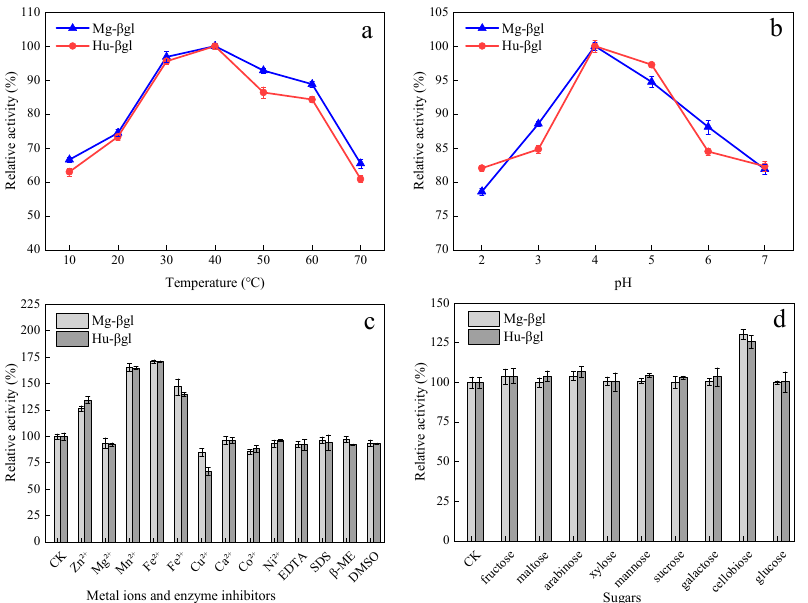
Figure 2. Temperature ( a ), pH ( b ), metal ions and enzyme inhibitors ( c ), and various sugars ( d ) profiles of the activity of the purified enzymes Mg- β gl and Hu- β gl. The values represent the mean of three replicate determinations. The error bars represent SD.